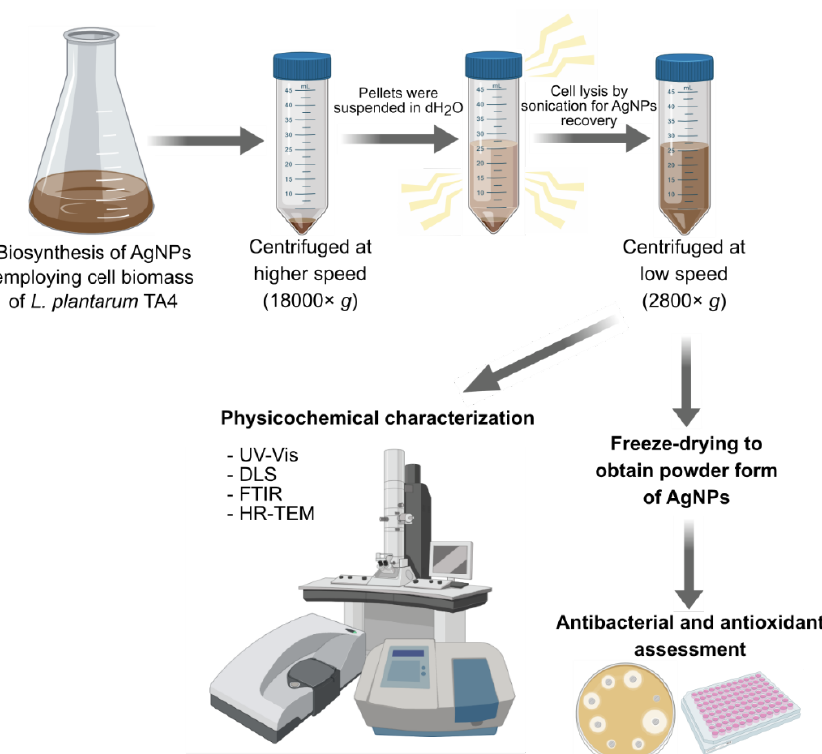
Figure 1. Schematic representation for biosynthesis, characterization, and biopotential applications of biosynthesized silver nanoparticles (AgNPs).